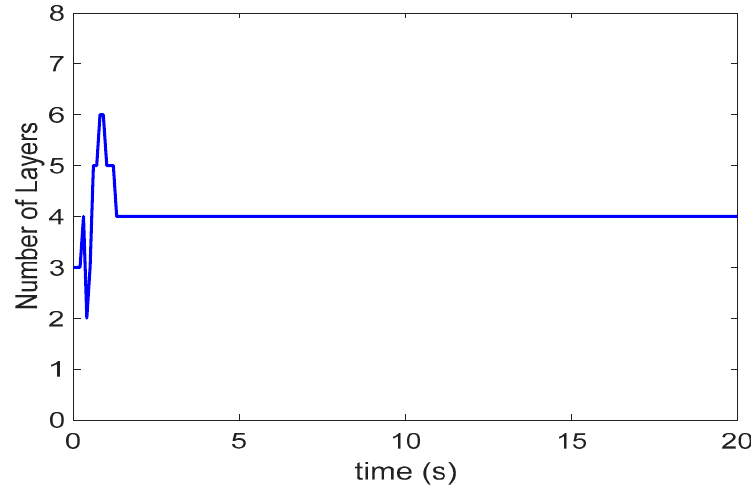
Figure 11. Number of layers using self-evolving algorithm for Case 1.